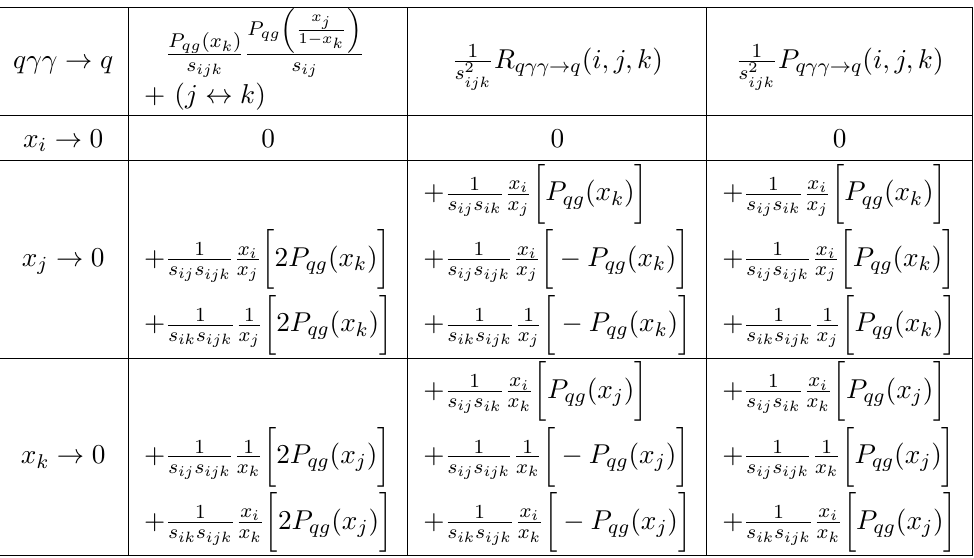
Table 3 . Singular behaviour of the P qγγ → q triple collinear splitting function in the limit where individual momentum fractions are